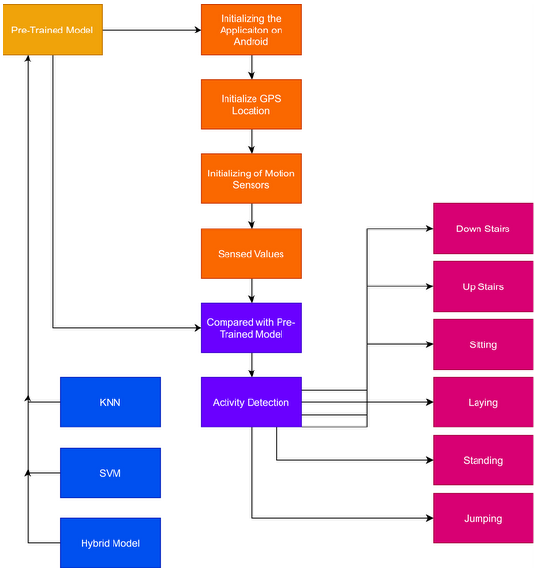
Figure 3. Proposed Methodology for